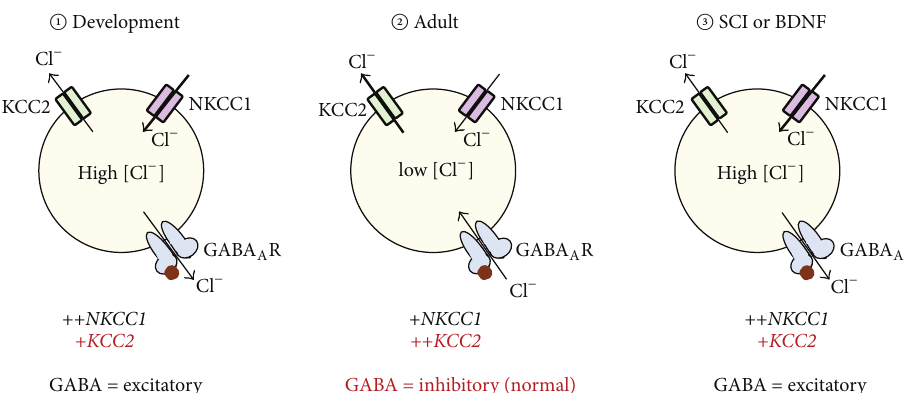
Figure 7: Plasticity in GABA-mediated chloride function; role of chloride transporters KCC2 and NKCC1. A During development, CNS neurons express high levels of NKCC1 and low levels of KCC2. Upon GABA binding GABA A receptors, chloride ions [Cl − ] exit the cell, thereby producing excitatory actions. B In mature cells, the reverse occurs. The high concentration of KCC2 causes [Cl − ] to enter the cell, which results in GABAergic inhibitory actions. C Both SCI and BDNF have been shown to decrease membrane bound KCC2 expression